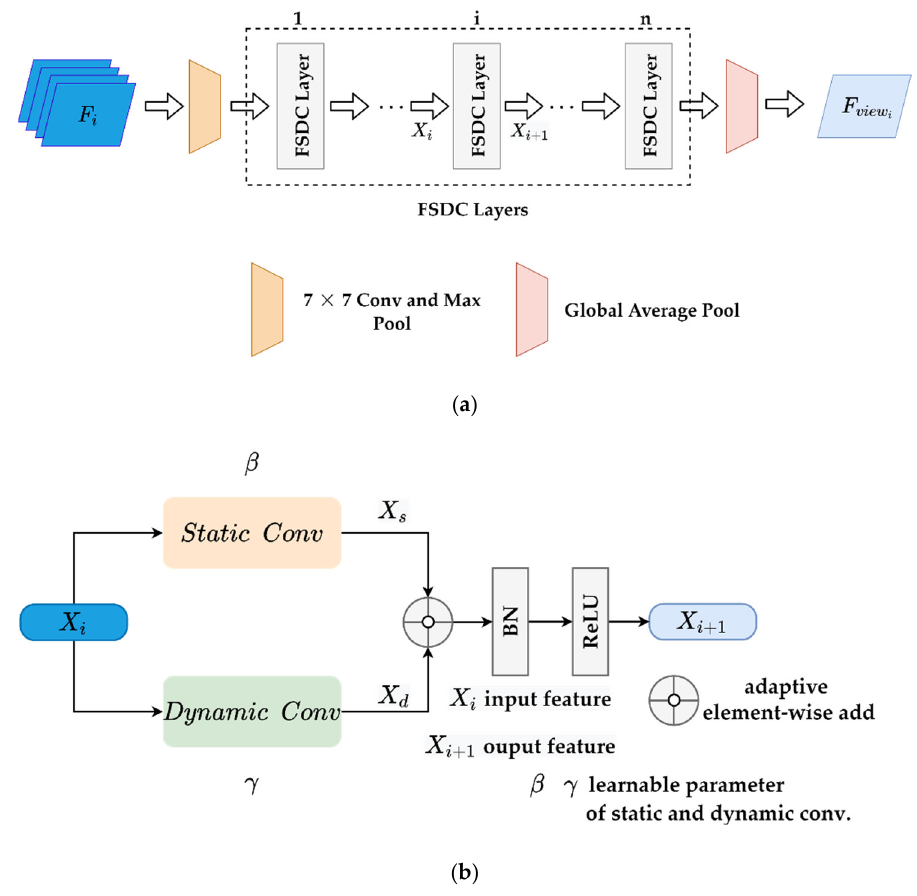
Figure 4. FSDC local feature extraction. ( a ) The architecture of local feature extraction. ( b ) The structure of the i-th FSDC layer.